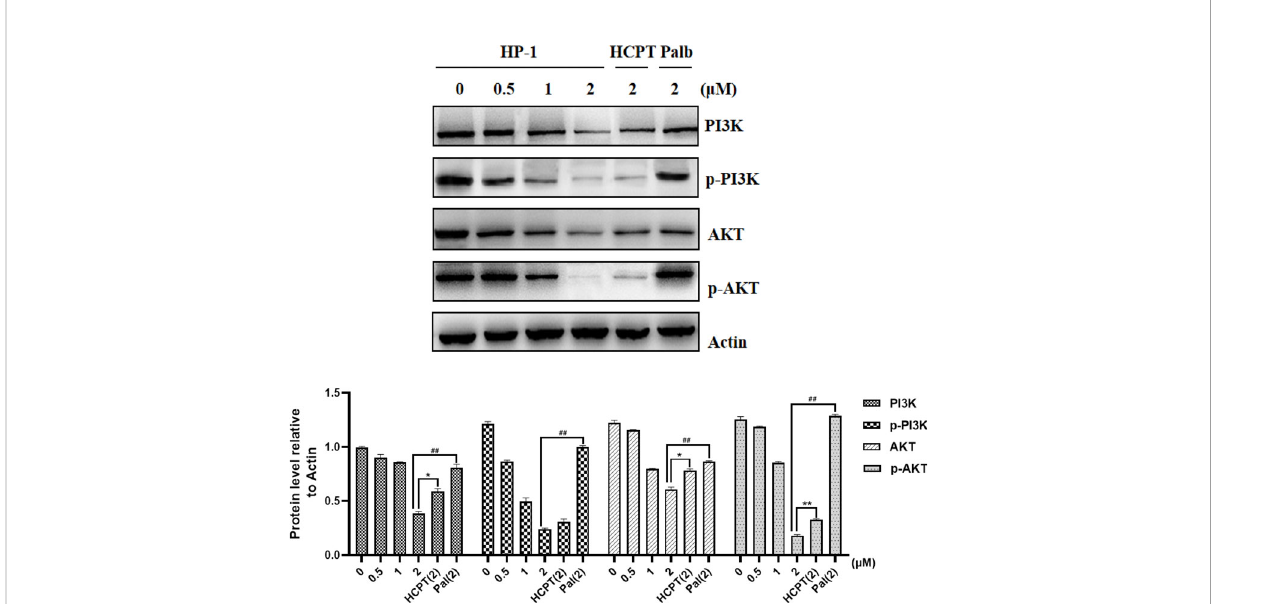
FIGURE 8 Effect of HP-1 on the expression level of PI3K/AKT pathway-related proteins in NCI-H460 cells. Data shown are the mean ± SEM of three independent experiments (* p <0.05, ** p <0.01, compared to HCPT; ## p <0.01, compared to